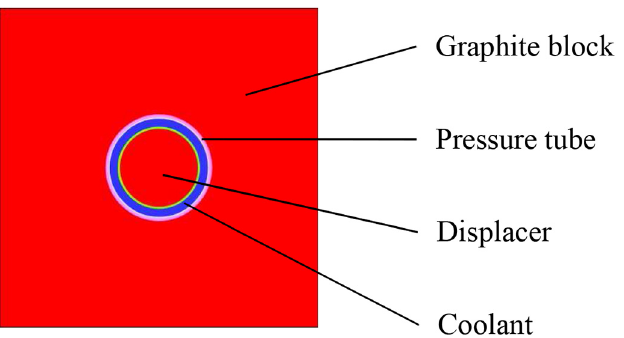
Fig. 5. Sectional view of CPS with the